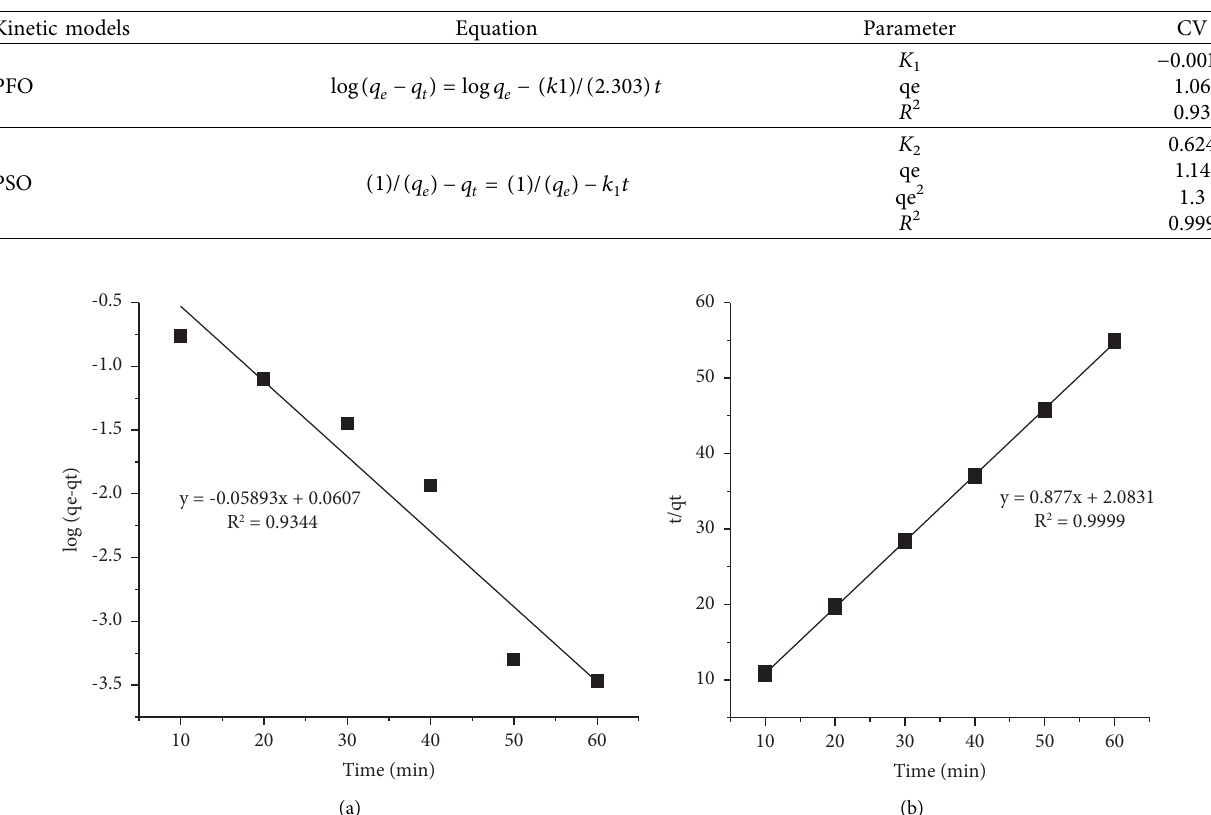
Table 3: Linear kinetic model equation and calculated parameter value.